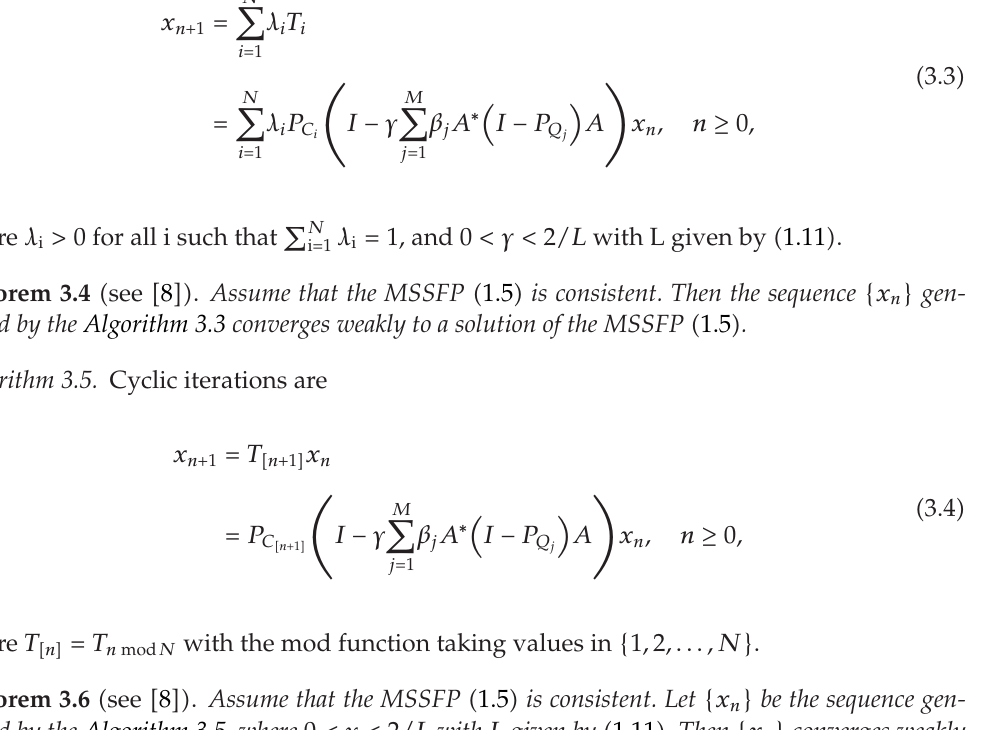
Algorithm 3.3. Parallel iterations are